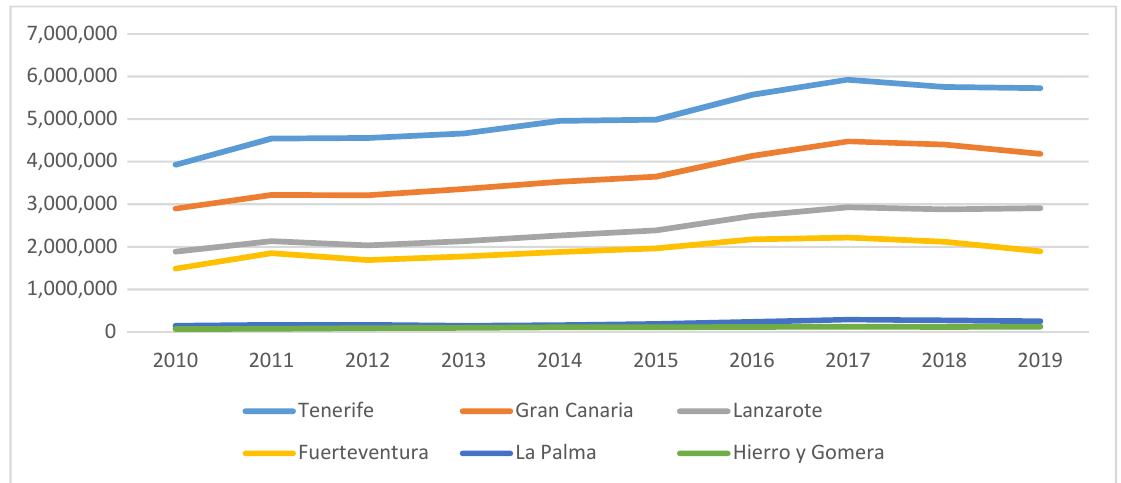
Figure 2. Tourist arrivals to the different islands (2010–2019). Source: Own elaboration with data from Turismo de Canarias (Canary Islands Tourism). Table 1. Tourists by nationality (in thousands) arriving in Gran Canaria in 2019. Source: Own elaboration with data from Turismo de Canarias (Canary Islands Tourism).